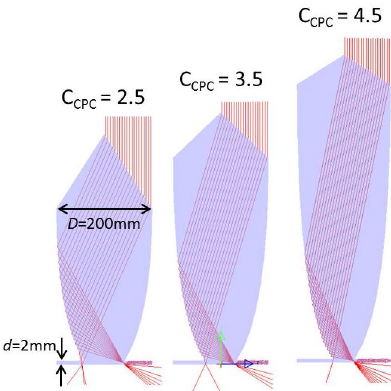
Figure 7. Schematic diagram of ray-tracing results for the P-CPC concentration system with different shapes of CPCs that have C CPC = 2.5; 3.5 and 4.5 .